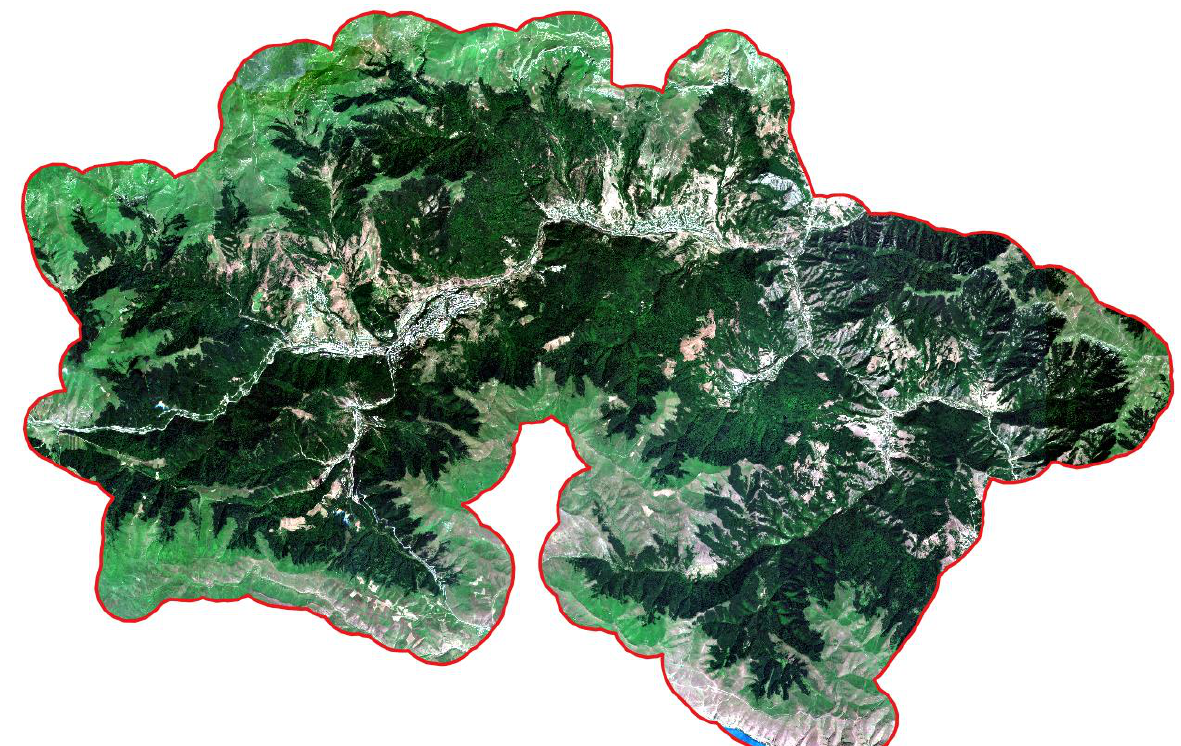
Figure 2. Sentinel-2 at 10 m spatial resolution acquired on 31/07/2019 @ESA.